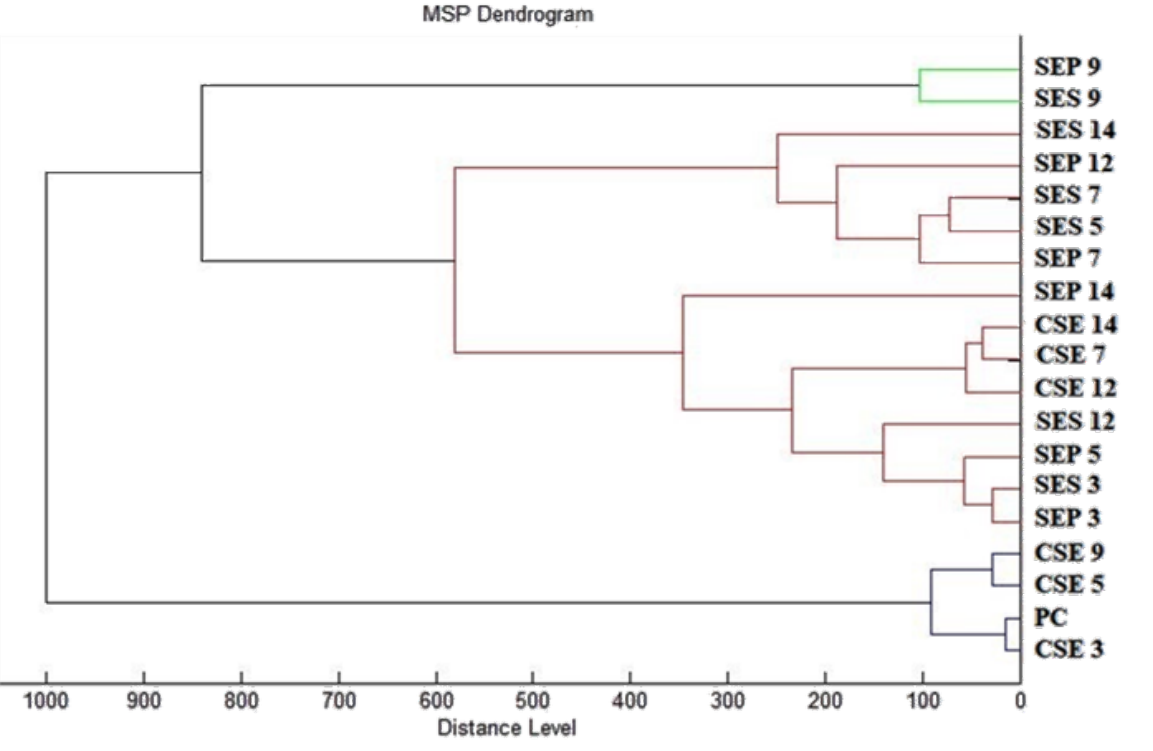
Figure 2. Dendrogram of S. enterica biofilm progress after FEO exposition. SE — S. enterica ; C — control; S — stainless steel; P — plastic; PC — planktonic cells. Table 9. Anti-insect activity of